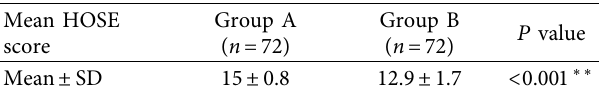
Table 4: The difference between the total HOSE scores for both the groups was statistically